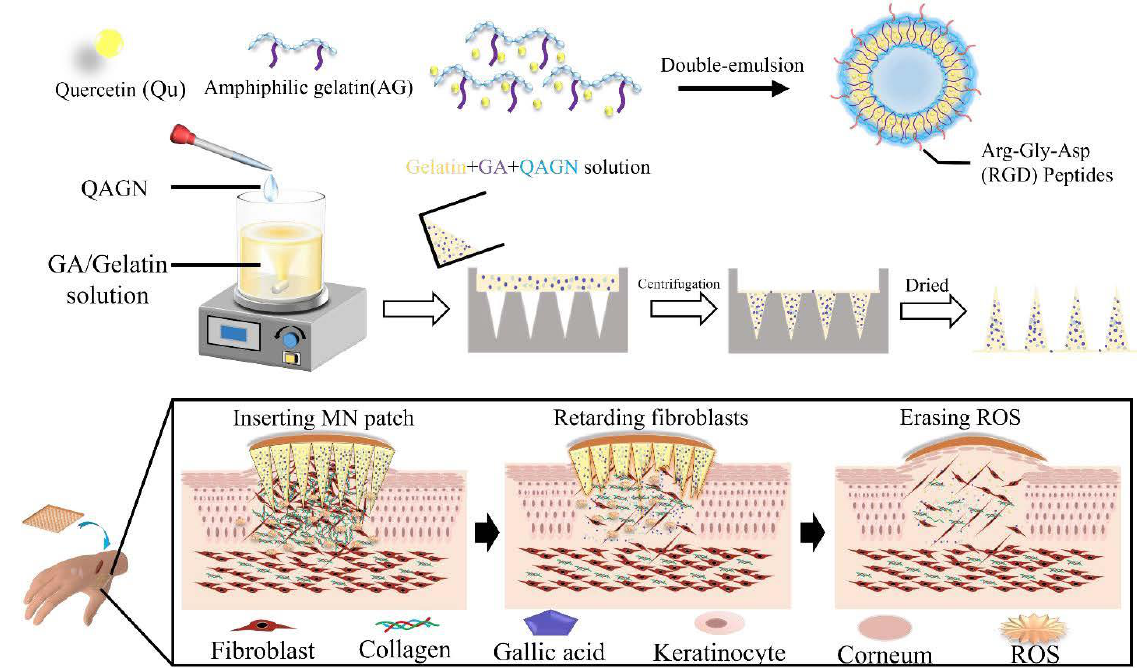
Figure 3. Schematic representation of the amphiphilic gelatin nanocarrier loaded with quercetin preparation and the mechanism of drug release. Keloid scarring can be treated by the transdermal delivery of drug combinations (Qu and gallic acids) via actions of gelatin-based MN composite heterogeneously. Adapted from Chen et al. [22].